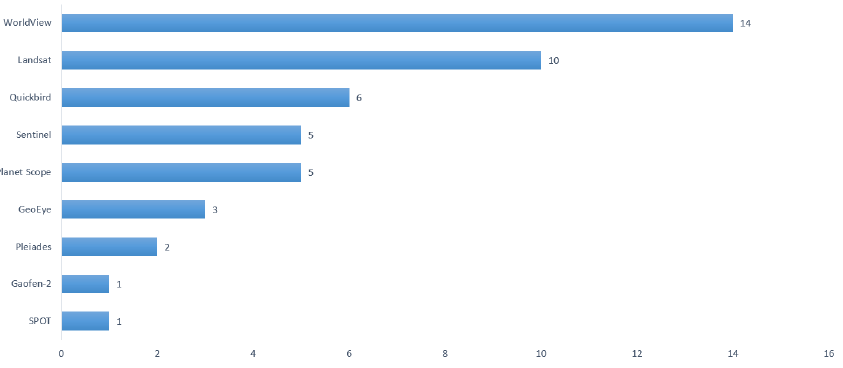
Figure 3. Most used satellites in coral reef classification and mapping between 2018 and